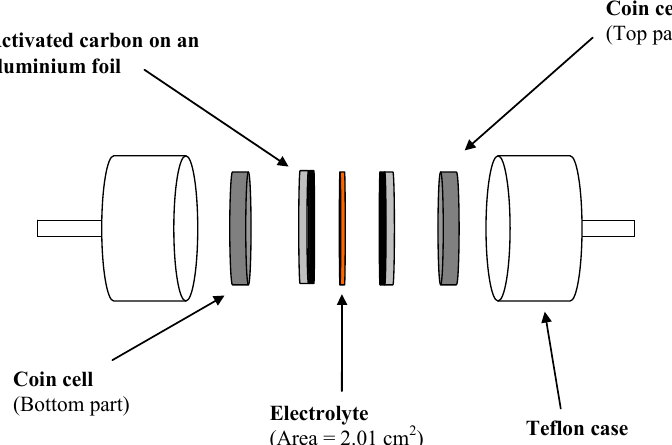
Figure 1. Schematic diagram of the electrical double-layer capacitor (EDLC) setup.